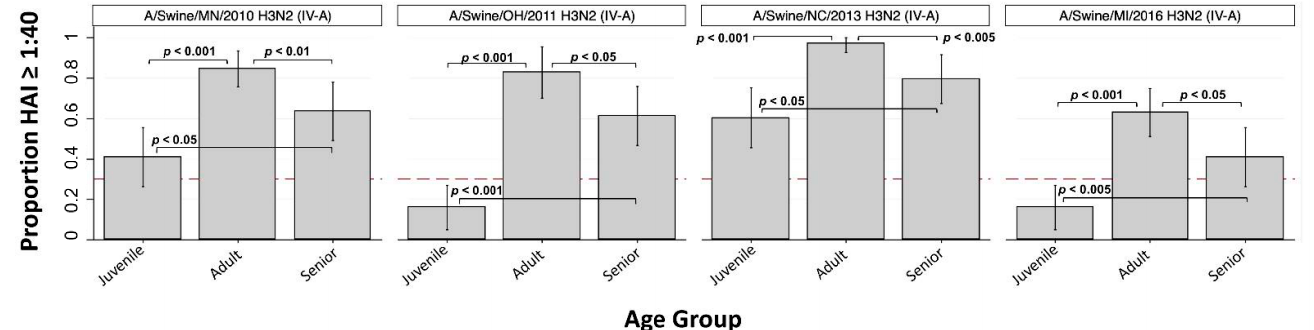
Figure 2. Seroprotection rate (SPR) against H3 cluster IV-A IAV-S by age group ( n = 3). Bar height indicates proportion of individuals with HAI antibody titer >1:40, which is the seroprotection rate (SPR) within Juvenile (<18 years old), Adult (18 to 49 years old), and Senior ( ≥ 50 years old) age groups. Dashed red line at y = 0.3 corresponds to SPR of 30%. Vertical spikes and caps indicate 95% confidence interval of the proportion. Significant difference in proportions between groups are indicated (when present) by horizontal brackets and p -values (Pearson’s chi-squared).